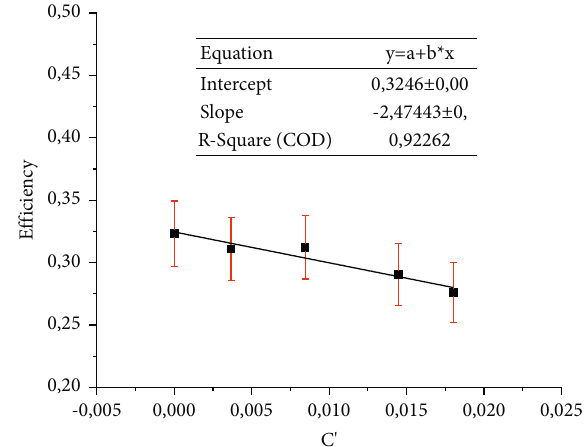
Figure 11: The collector efficiency as a function of temperature variation C ′ and the error bars plotted in this graph represent the standard deviation according to Table 3.